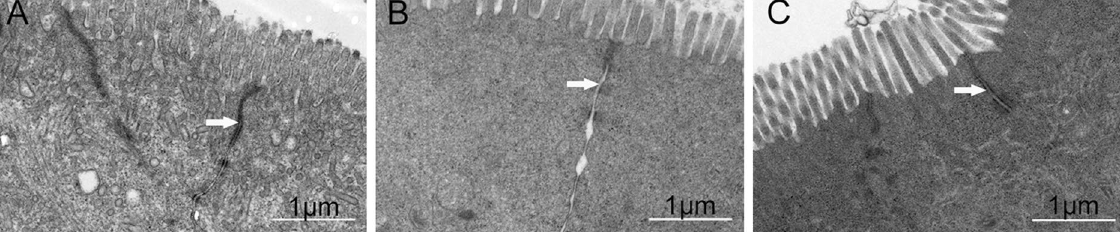
Figure 2. TJ structural changes in intestinal mucosal epithelial cells 48 h after oral intubation with A. hydrophila . ( A ) control (PBS) group, ( B ) A. hydrophila group, ( C ) B. subtilis + A. hydrophila group. In each panel, white arrows indicate tight junctions.